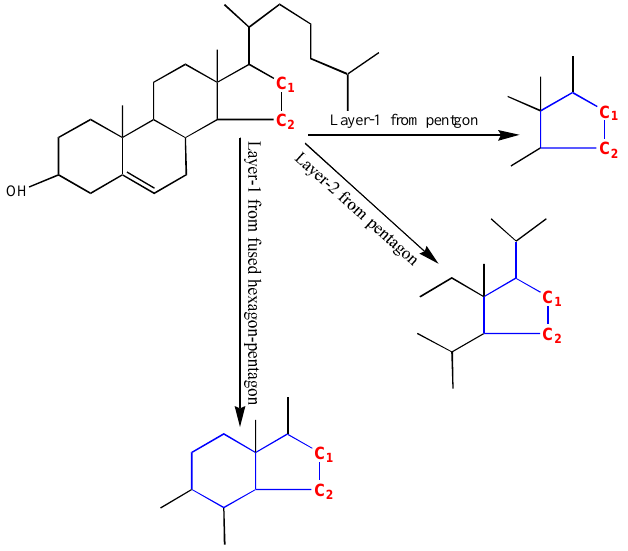
Figure 14. C and C have very different chemical shifts (C 1 2 substructure measurement should distinguish them. Topologically, if the pentagon is considered as core layer, C cannot be distinguished up to the second layer. But, if the fused hexagon-pentagon is measured as the core layer, C can be distinguished. The hexagon is encoded as remote fused ring in GACF substructure measurement C 2